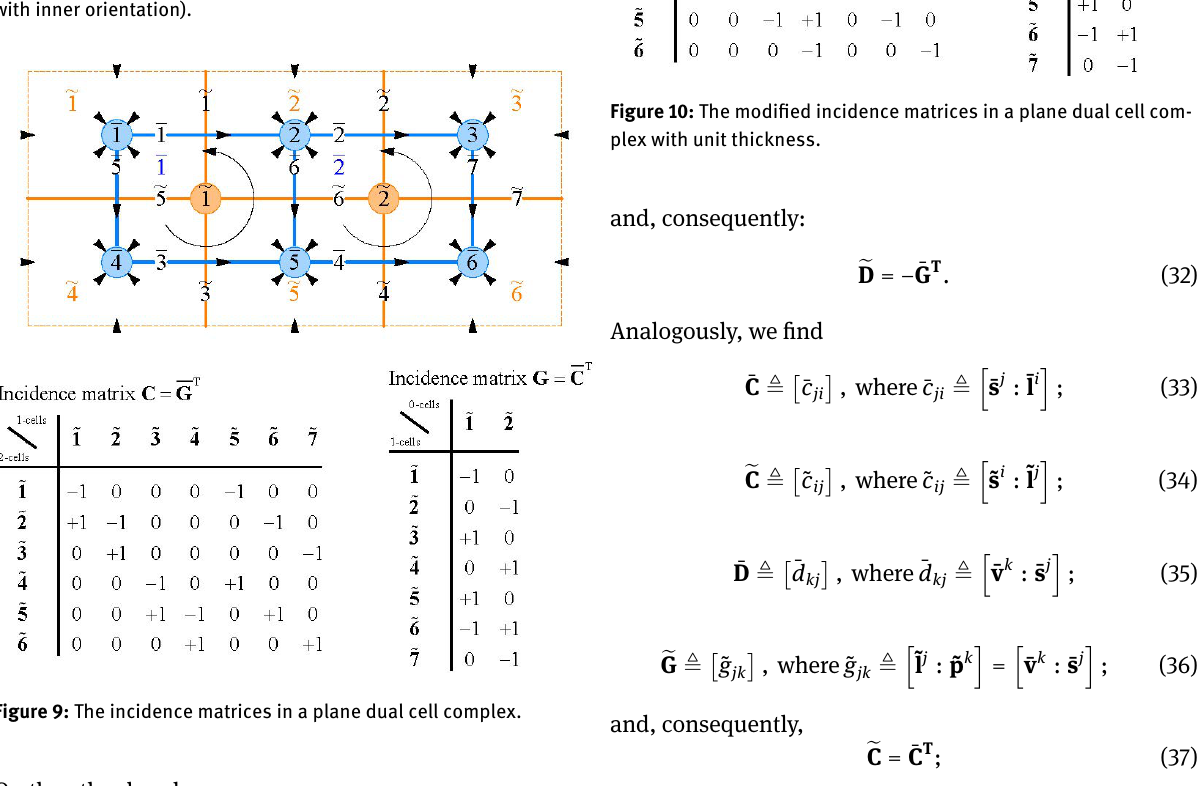
Figure 8: The incidence matrices in a plane cell complex (the symbol “ ¯ ” over the labels of the p -cells means that the p -cells are endowed with inner orientation).